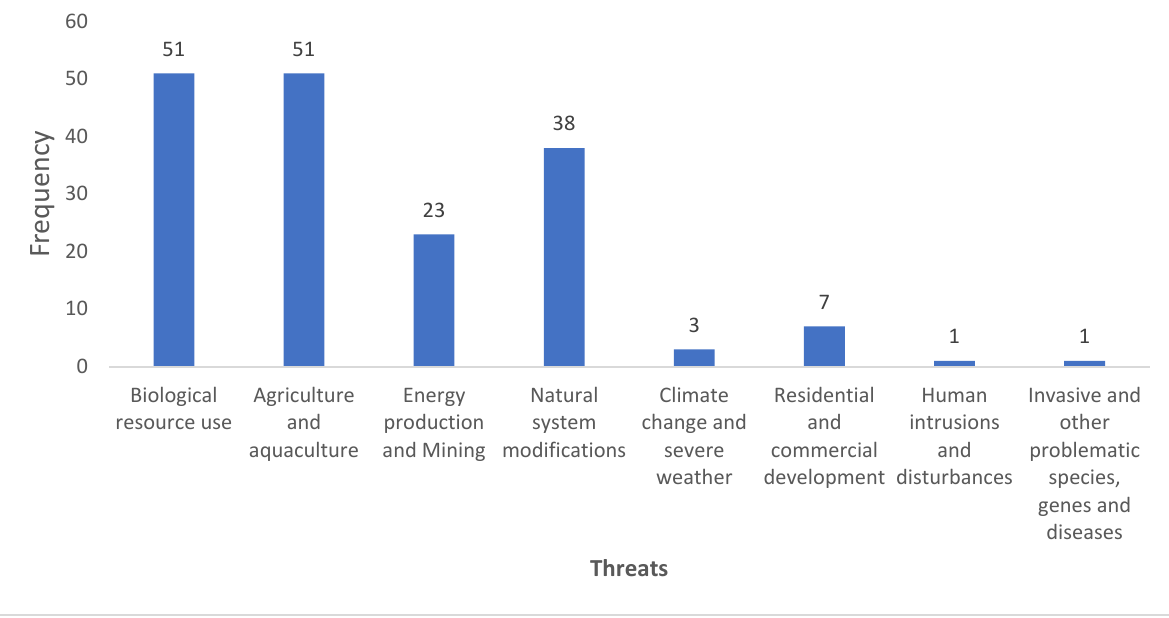
Figure 6. The most recorded threats from the IUCN database of the plant taxa.